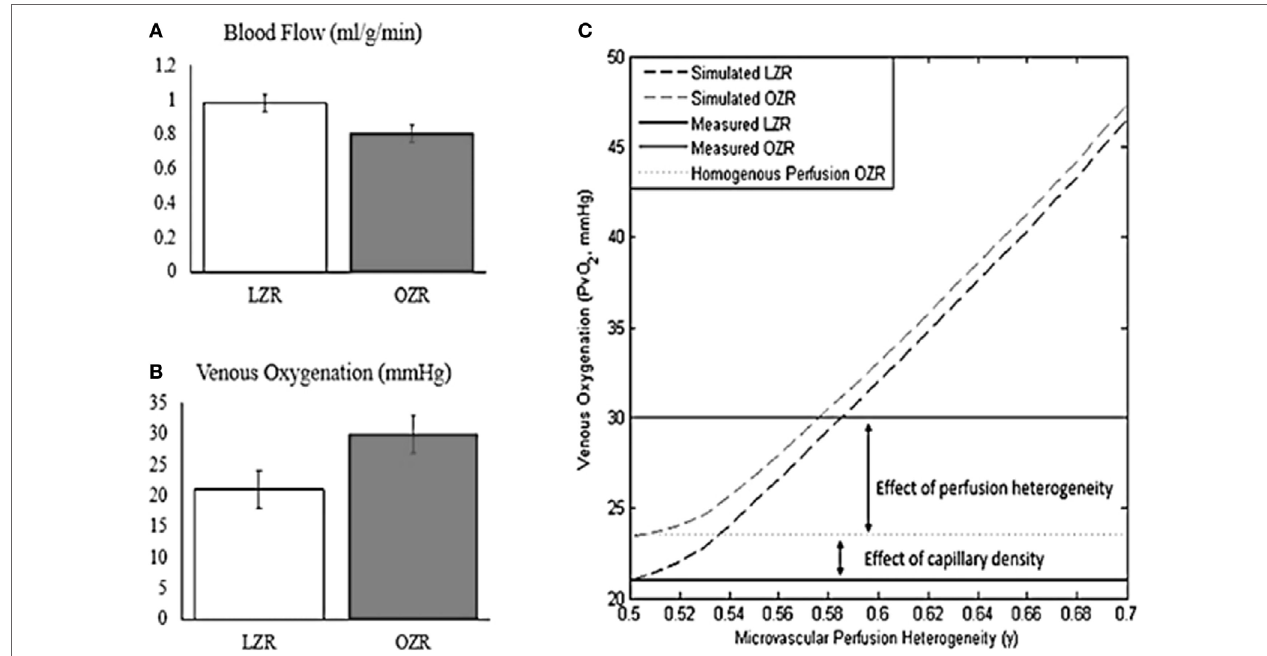
FiGURe 1 | Oxygen extraction fails to compensate for reduced blood flow under conditions of microvascular perfusion heterogeneity. Adapted from Mason McClatchey et al. (123). Copyright 2017 Springer US. (A) Blood flow during exercise is reduced by ~20% in the obese Zucker rat (OZR) relative to the Lean Zucker Rat. (b) Venous oxygenation during exercise is increased in the OZR relative to the Lean Zucker Rat, reflecting impaired oxygen extraction. (C) Computational modeling of oxygen transport reveals that the failure to compensate for reduced blood flow in the OZR can be explained by the combined effects of reduced capillary density and microvascular perfusion